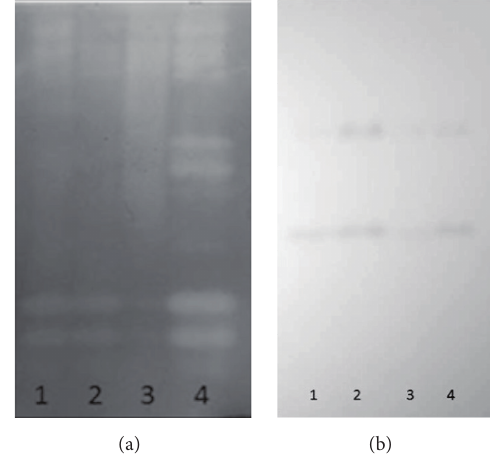
Figure 3: Expression profile analyzed by zymography: (a) endoglu- canase isoforms produced by M . heterothallica F.2.1.4. in submerged (Sm) and solid-state (SS) cultivation. Line 1, SSCWB; Line 2, SmCWB; Line 3, SSCP; and Line 4, SmCP; (b) 𝛽 -glucosidases produced by submerged and solid-state cultivation. Line 1, SSCWB; Line 2, SmCWB; Line 3, SSCP; and Line 4,